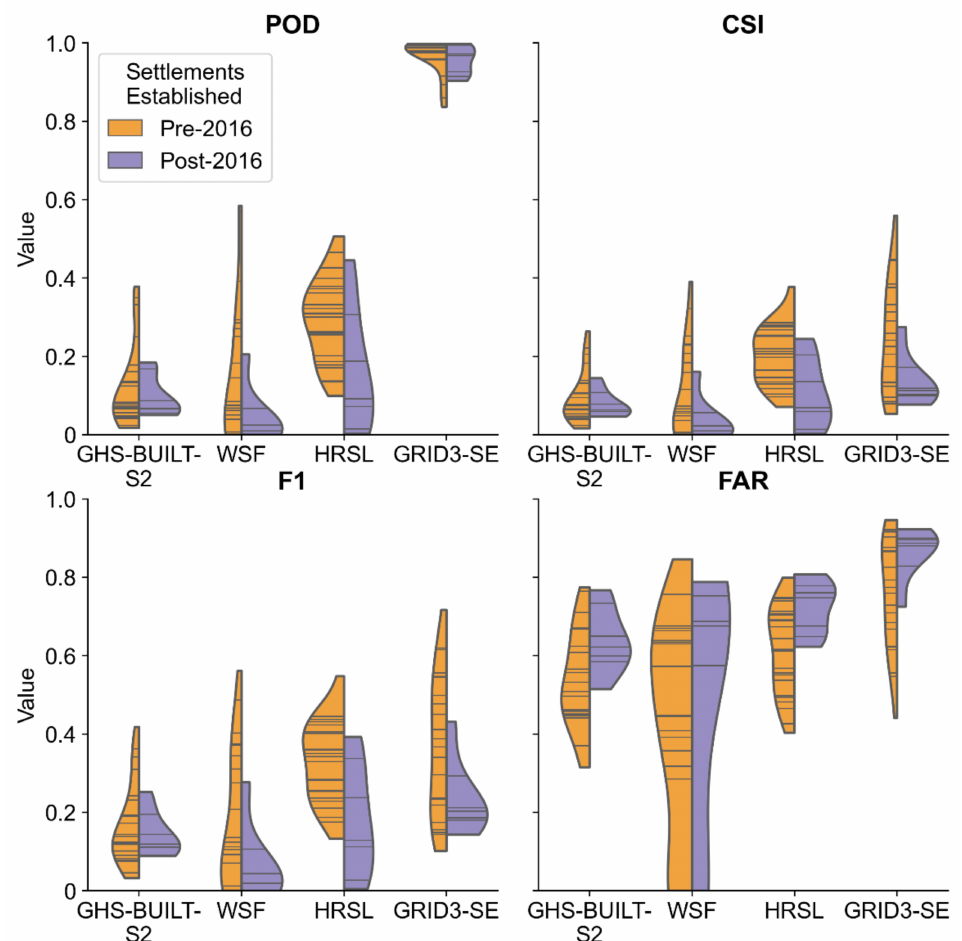
Figure 9. Violin plots of probability of detection (POD), critical success index (CSI), F1-score (F1) and false alarm rate (FAR) detection metrics for individual settlement products compared to the OSM–MS building footprint dataset for pre- and post-2016 settlements. Black horizontal lines in violin plots represent individual settlement observations. GHS-BUILT-S2, Global Human Settlement Layer with Sentinel 2; WSF, World Settlement Footprint; HRSL, High Resolution Settlement Layer; GRID3-SE, Geo-Referenced Infrastructure and Demographic Data for Development settlement extent